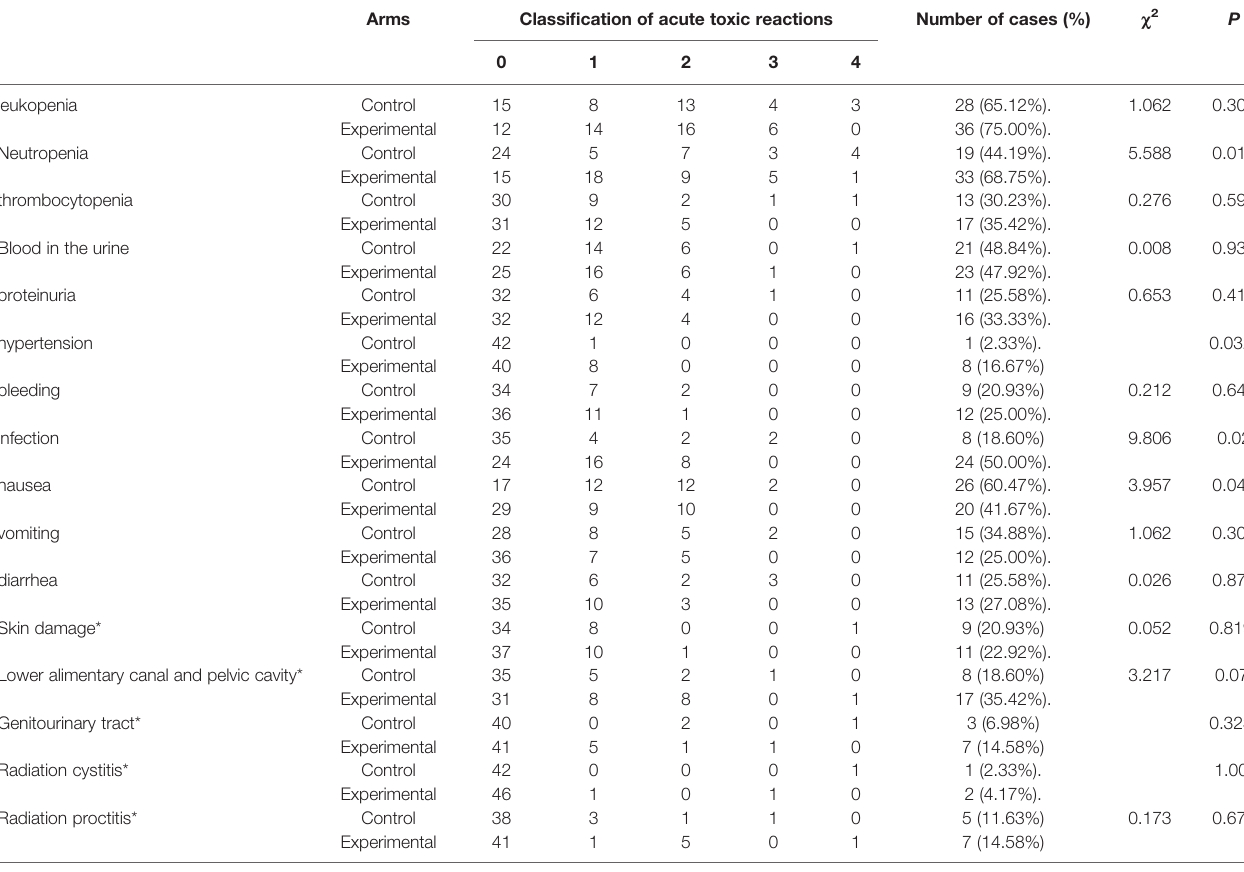
TABLE 3 | The occurrence and comparison of acute toxic and side effects between the two groups. Arms Classi fi cation of acute toxic reactions Number of cases (%)